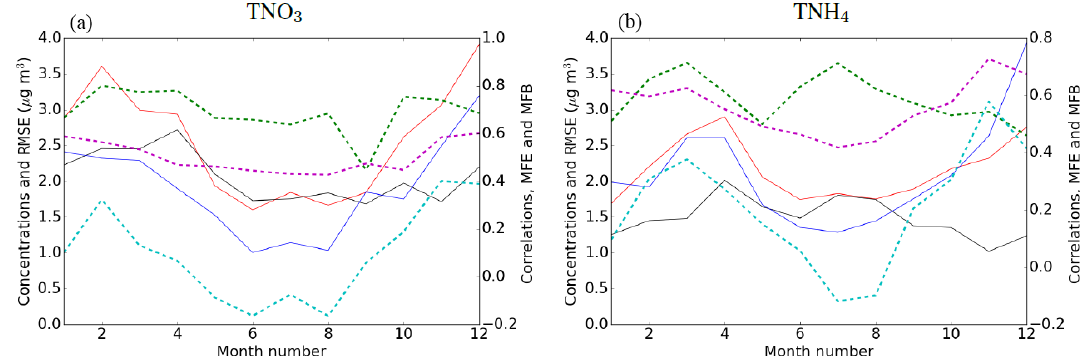
Figure 5. Modeled concentrations (in µgm − 3 ) and MFB for coarse NO − panel (a) and to the MFB value in panel (b) .